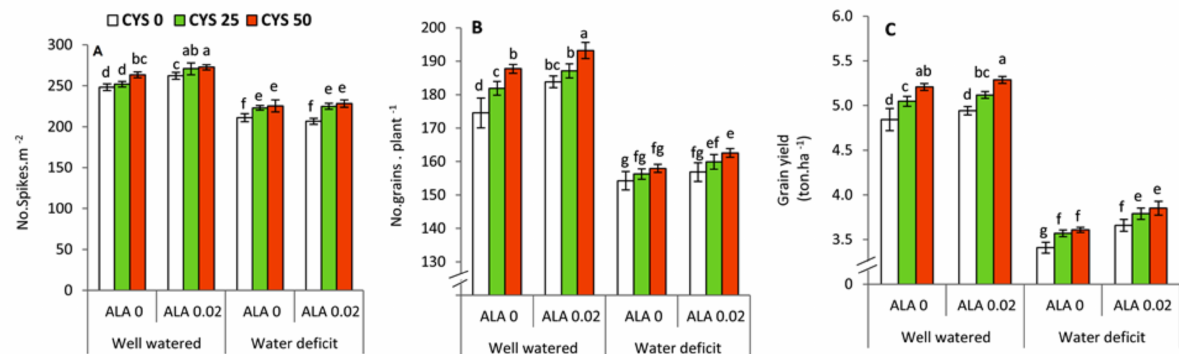
Figure 6. Effect of irrigation level, seed soaking by α -lipoic acid (ALA; 0 and 0.02 mM) and foliar application by cysteine (Cys; 0, 25 and 50 ppm) on grain yield and its components of wheat plants. ( A ) number of spikes, ( B ) number of grains, ( C ) Grain yield. For each parameter, the mean values ± SD followed by a different letter are significantly different according to Tukey’s range test ( p ≤